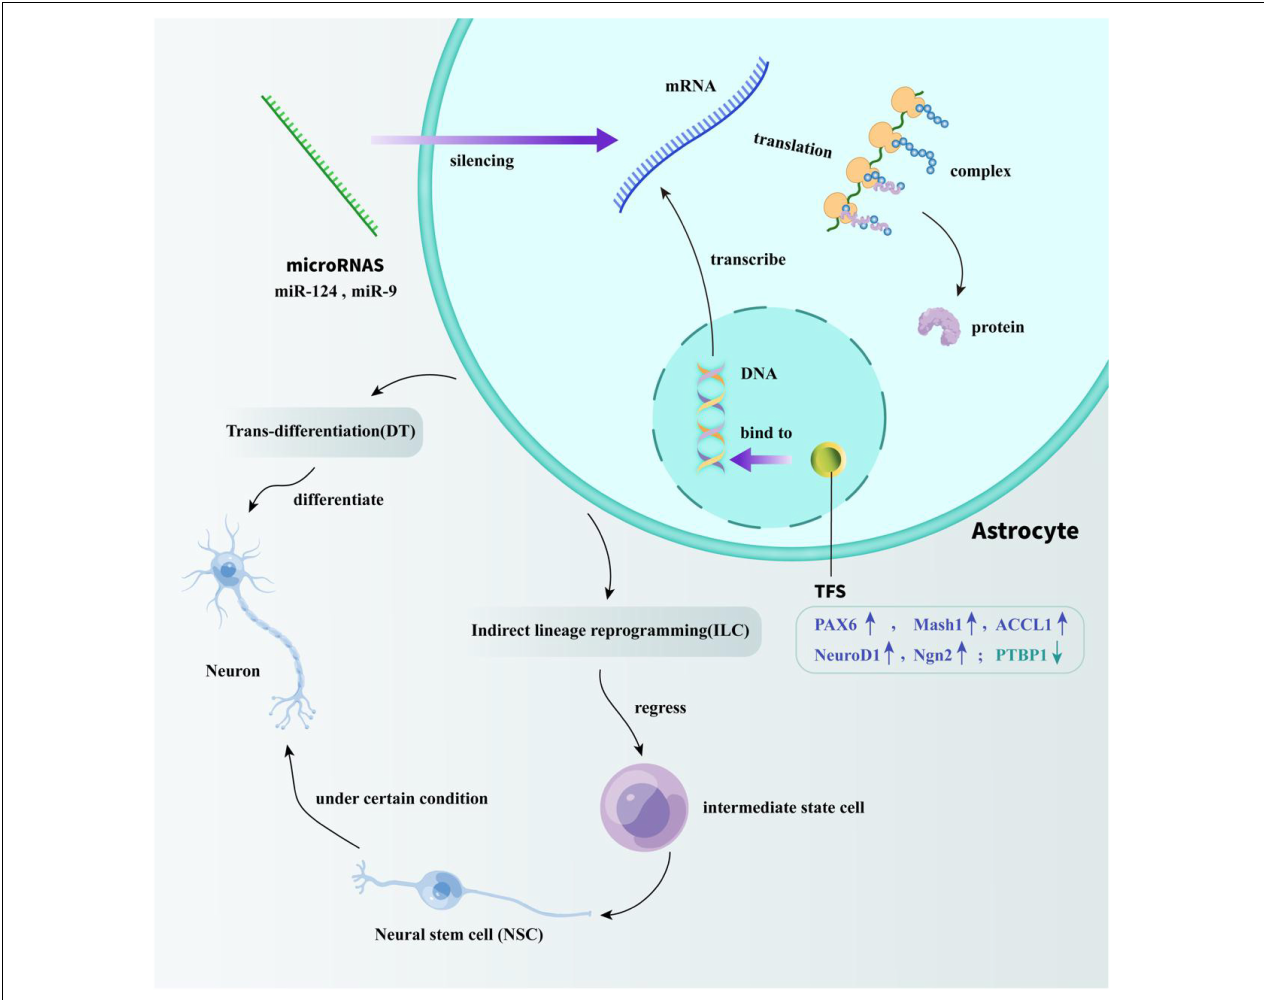
FIGURE 1 | Specific mechanisms of TFs and microRNAs acting on astrocyte reprogramming. TFs modulate the efficiency of gene transcription by binding to DNA-regulatory sequences. miRNAs play a regulatory role by silencing transcriptionally generated mRNA. Through the regulation of TFs and miRNA, the trans-differentiation of astrocytes into neurons in vivo can be successfully achieved. One way is directly reprogramming astrocytes into neurons. The other way is by regressing astrocytes into intermediate state cells, and then differentiate into NSCs to indirectly obtain mature